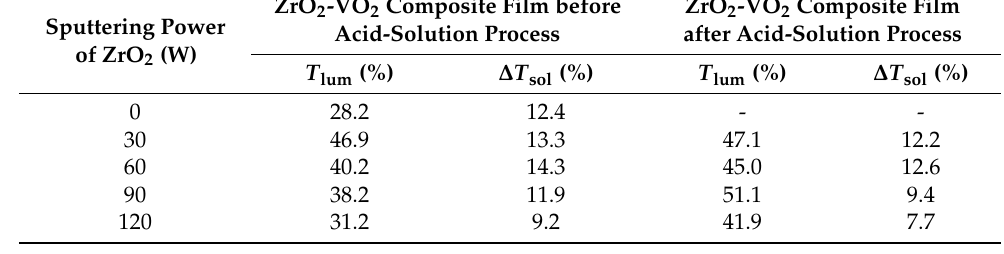
Figure 5. Comparison of ( a ) ∆ T sol and ( b ) T lum between ZrO 2 -VO 2 composite films (before the acid- solution process) and island-like ZrO 2 -VO 2 films (after the acid-solution process) with different sputtering powers of the ZrO 2 target. Table 2. The solar-modulation efficiency ( Δ T sol ) and visible transmittance ( T lum ) of the obtained films.